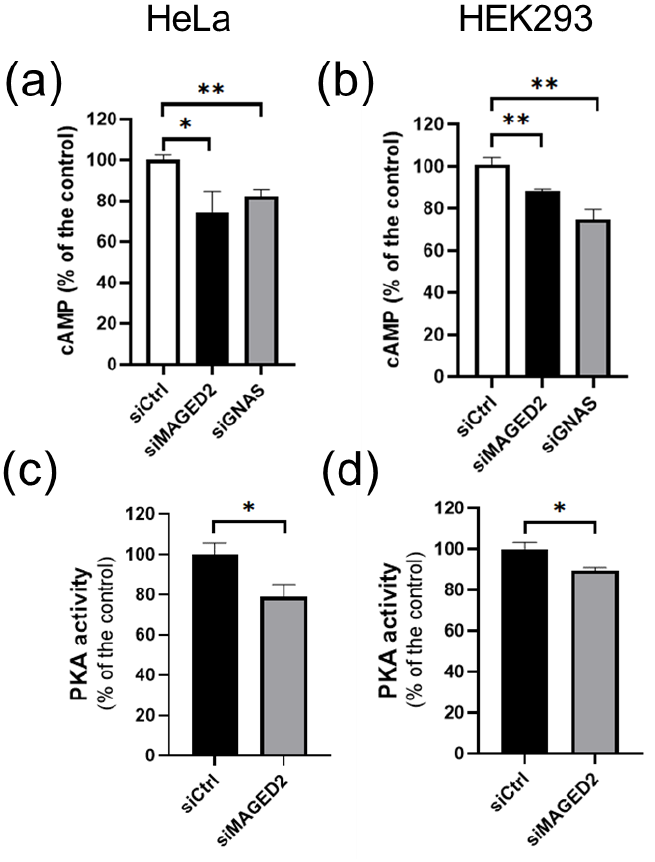
Figure 3. MAGED2 depletion decreases cAMP production and PKA activity under hypoxic condition. HeLa ( a , c ) and HEK293 ( b , d ) cells were transfected with control, MAGED2 and G α s siRNA. In 24–48 h post-transfection, growth medium was replaced by DMEM serum free supplemented with 300 µ M Cobalt chloride (CoCl 2 ). ( a , b ) Cells were lysed with 0.1 M HCL containing 0.1% Triton X-100 and cAMP was measured by ELISA. ( c , d ) Cells were lysed with PKA extraction buffer and PKA activity was measured with the PepTag Nonradioactive Protein Kinase Assay Kit. Statistical significance was determined by unpaired two-sided Student’s t tests. All data are shown as a representative result from three independent experiments. Bar graphs show mean ± SEM. * p ≤ 0.05 and ** p ≤ 0.01.